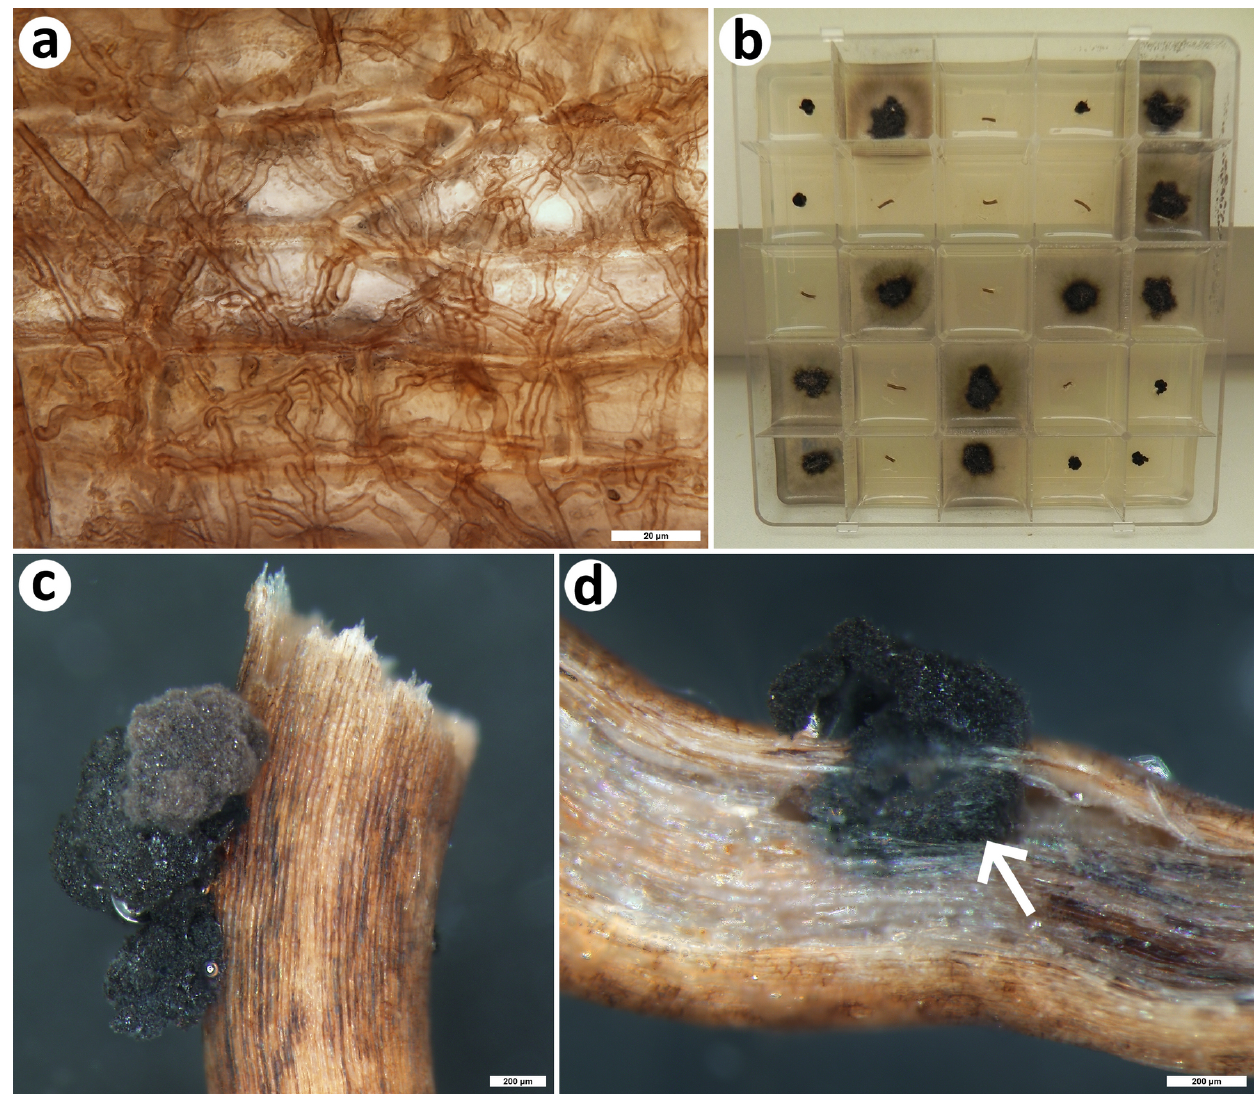
Figure 5. Colonization pattern and root mycobionts of the dominant Mediterranean seagrass Posidonia oceanica . (a) The typical colonization pattern in the seagrass roots that resembles the ubiquitous terrestrial dark septate endophytes, light microscopy; (b) 25-compartment plastic Petri dish filled with nutrient medium and with fungal colonies emerging from some of the surface-sterilized seagrass root segments. Note that one morphotype produces diffuse substrate mycelium (it corresponds to MOTU no. 14, i.e., the Lulworthiales sp. MV-2018; see Table 3), while the other remains small and limited to the surface of the root segments or their immediate vicinity (MOTU no. 13, i.e., Posidoniomyces atricolor ). In this particular case, nine root segments did not yield any fungal mycelium; that is, the isolation success reached 64%. (c) Detail of compact colonies of P. atricolor emerging from a surface-sterilized root segment, stereomicroscopy; bar is 200µm; (d) longitudinal section through a root segment yielding a compact colony of P. atricolor ; note that the surface mycelium originates from an enlarged intraradical sclerotium (arrow), stereomicroscopy; bar is 200µm. All photos taken by Martin